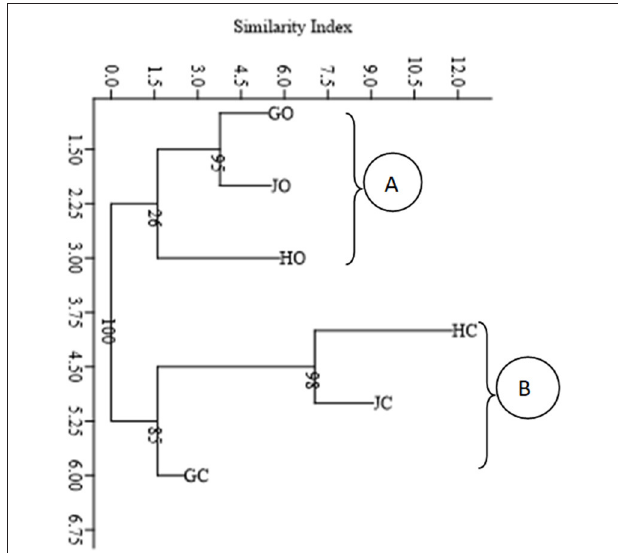
FIGURE 2 | Cluster diagram showing morphological distribution of the nodule isolates based on Neighbor joining method and Euclidian similarity index. The numbers shown at the nodes of the dendrogram indicate the percentage bootstrap support value after 1,000 resampling.